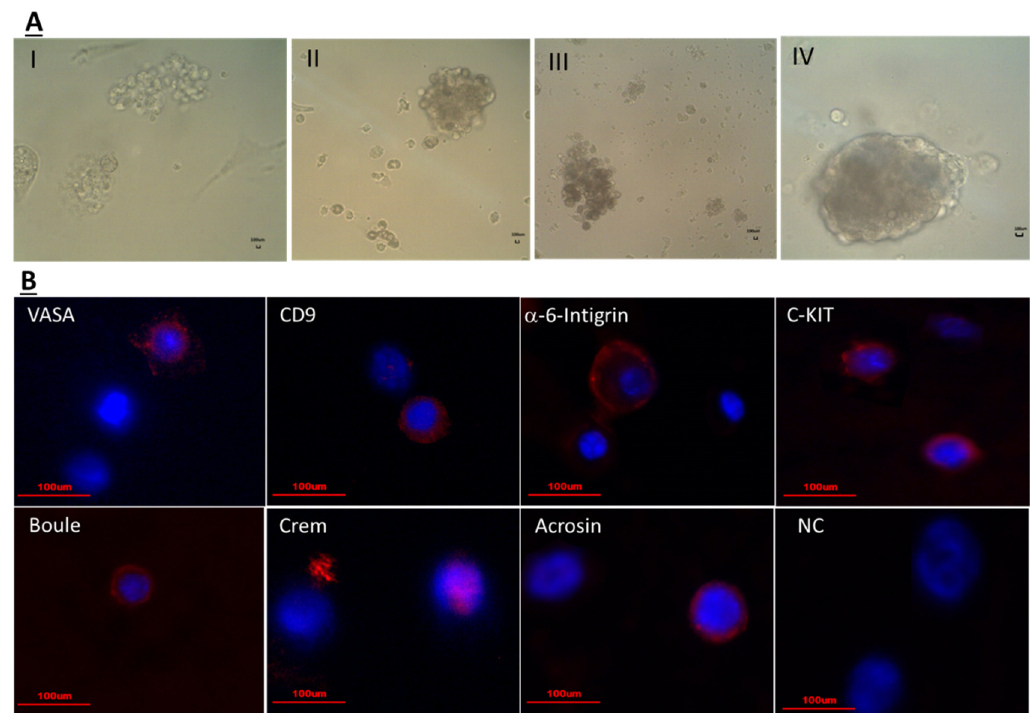
Figure 4. Isolated cells from seminiferous tubules of CP-treated immature mice developed colonies in vitro in methylcellu- lose culture system (MCS): Isolated cells from seminiferous tubules of CP-treated immature mice, ten days after the last injection were cultured in a methylcellulose culture system (MCS). The MCS was composed of 42% methylcellulose, KSR (10%), StemPro, and growth factors (GDNF, LIF, FGF, EGF) as described in materials and methods section in the absence or presence of IL-1 α , TNF- α , FSH, testosterone (T), or both IL-1 α + T, TNF- α + T, FSH + T. Developed colonies after 4–5 weeks of culture are presented ( A ). The developed cells in the different treatments were positively stained for premeiotic markers (VASA, CD9, α -6-integrin, C-KIT), meiotic markers (Boule, Crem) and meiotic/post-meiotic marker (Acrosin) as examined by immunofluorescence staining using specific primary antibodies for each cell type and the secondary antibody Cy3 (red color) and DAPI (blue color) that stained the nucleus of the cells ( B ). Scale bare: 100 µm.